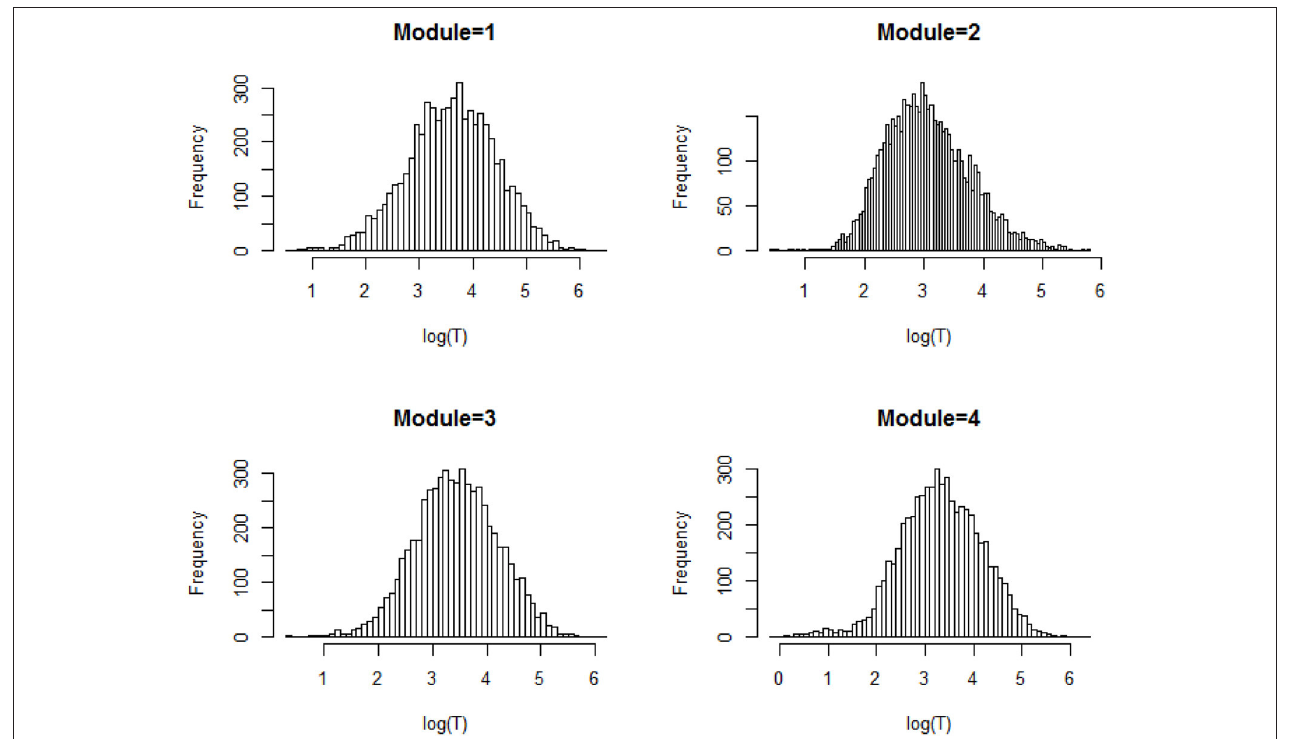
FIGURE 2 | Histogram of the log response time for all person-item combination across four modules.